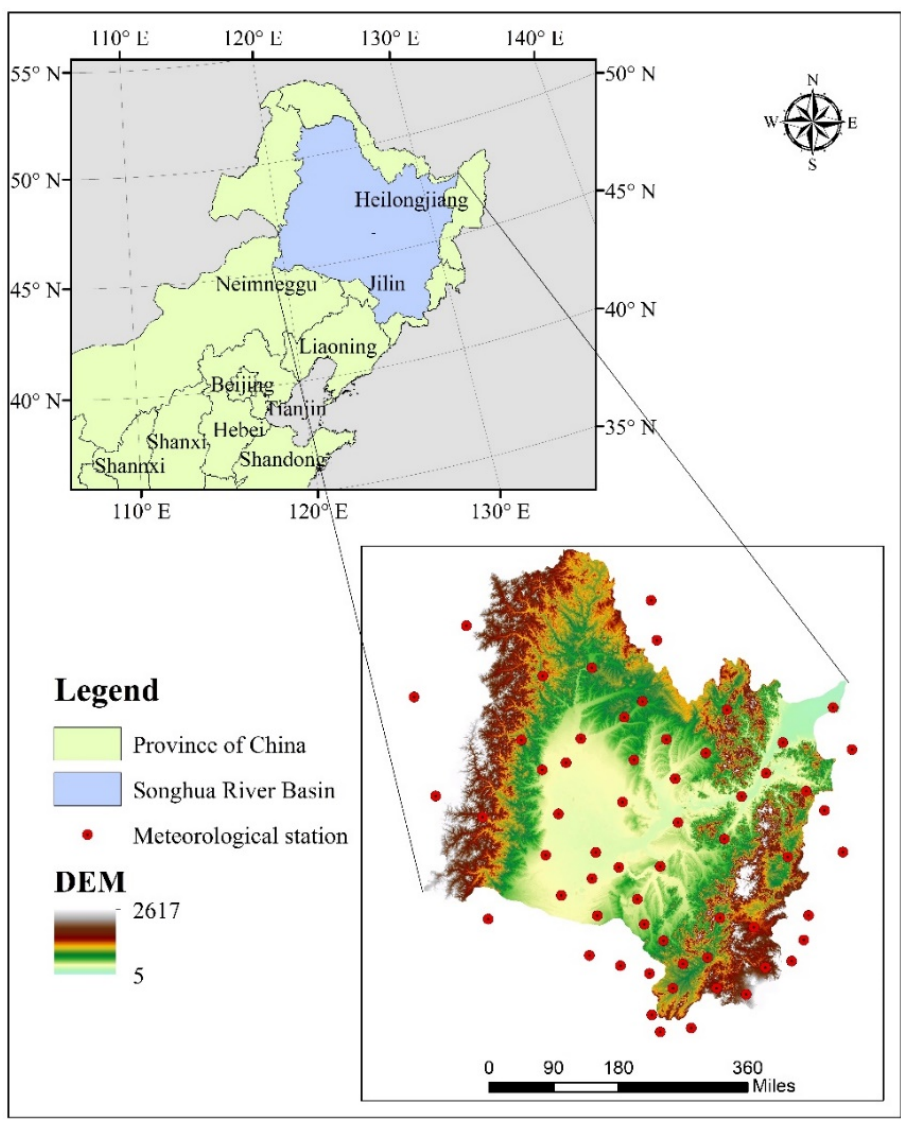
Figure 1. Location and elevation distribution of the SHRB and the distribution of the weather stations used for this study.